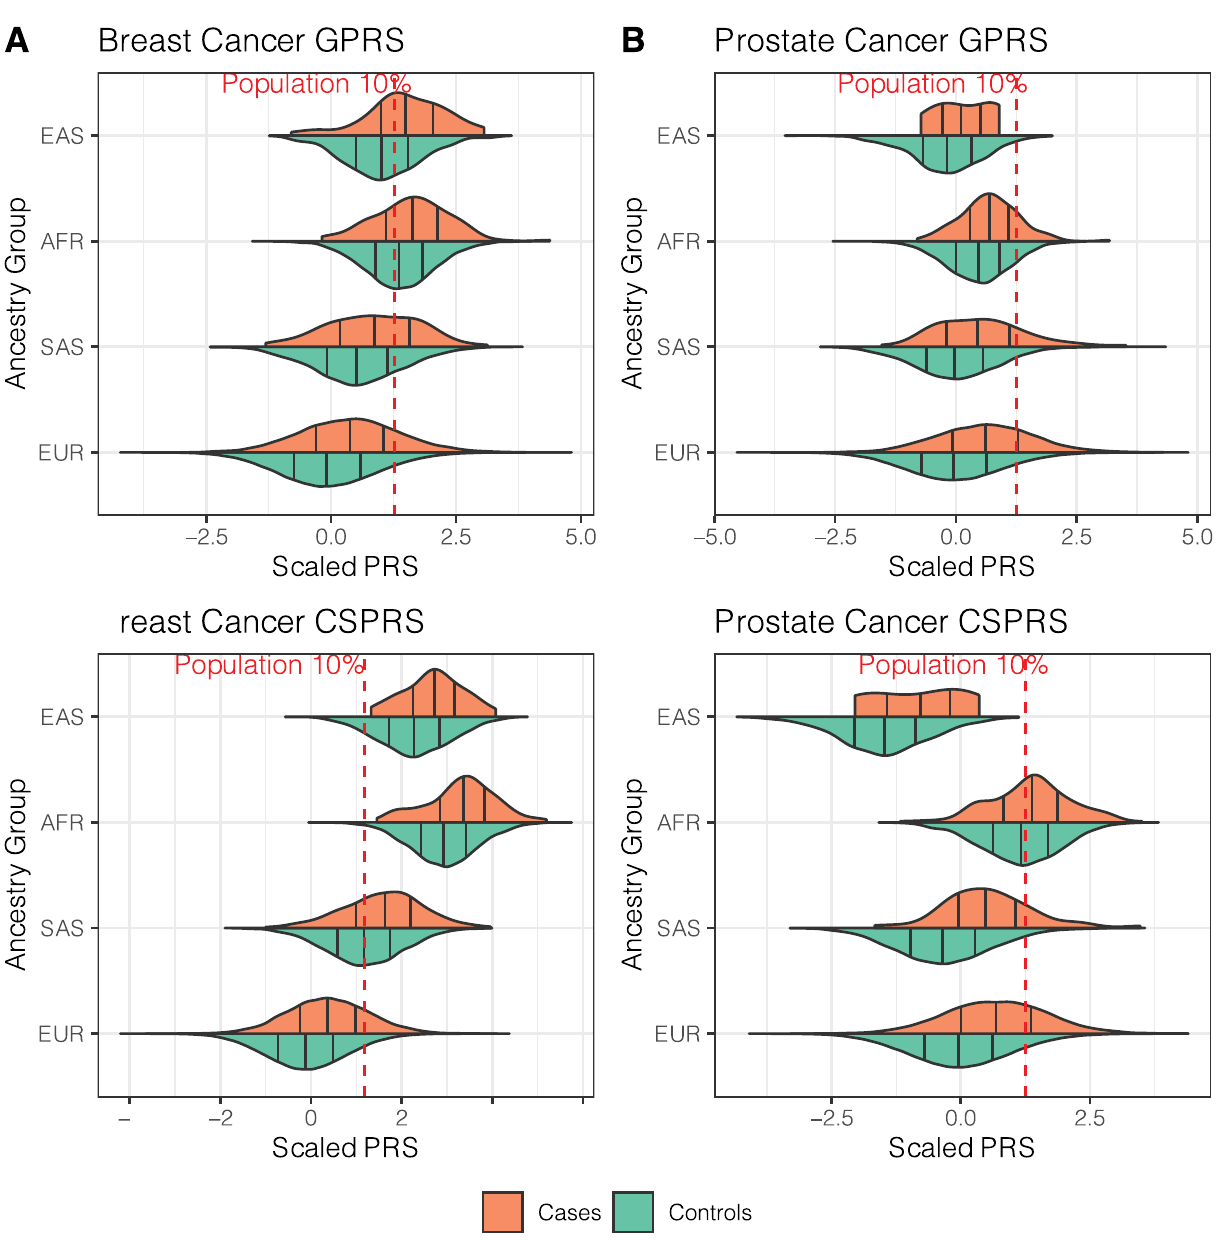
Fig 1. Violin plots of the breast and prostate cancer PRS distributions. Breast cancer (left) and prostate cancer (right) GPRS (GWAS hit-based PRS, top) and CSPRS (PRS-CS-based PRS, bottom) stratified by ancestry group are shown. Black vertical lines indicate 25, 50, and 75% quantiles within the ancestry- specific case (orange) and control (green) distributions. Red lines indicate 10% quantiles of the corresponding UKB PRS distribution in all controls. Sample sizes for each sub-set can be found in Table 1.